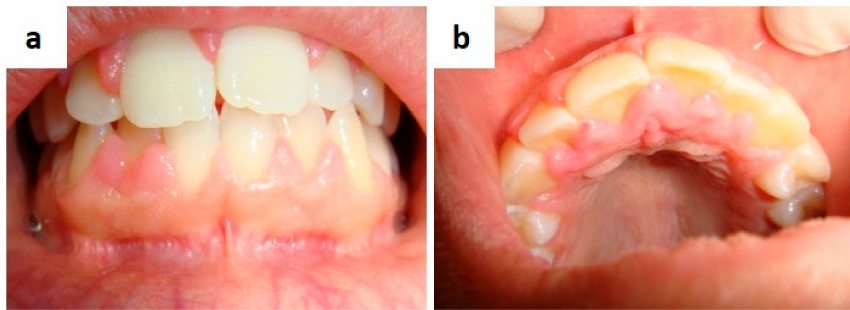
Figure 14. ( a , b ) Anticonvulsants-induced gingival overgrowth in young involving the interdental papillae and the adherent gingiva of both jaws.